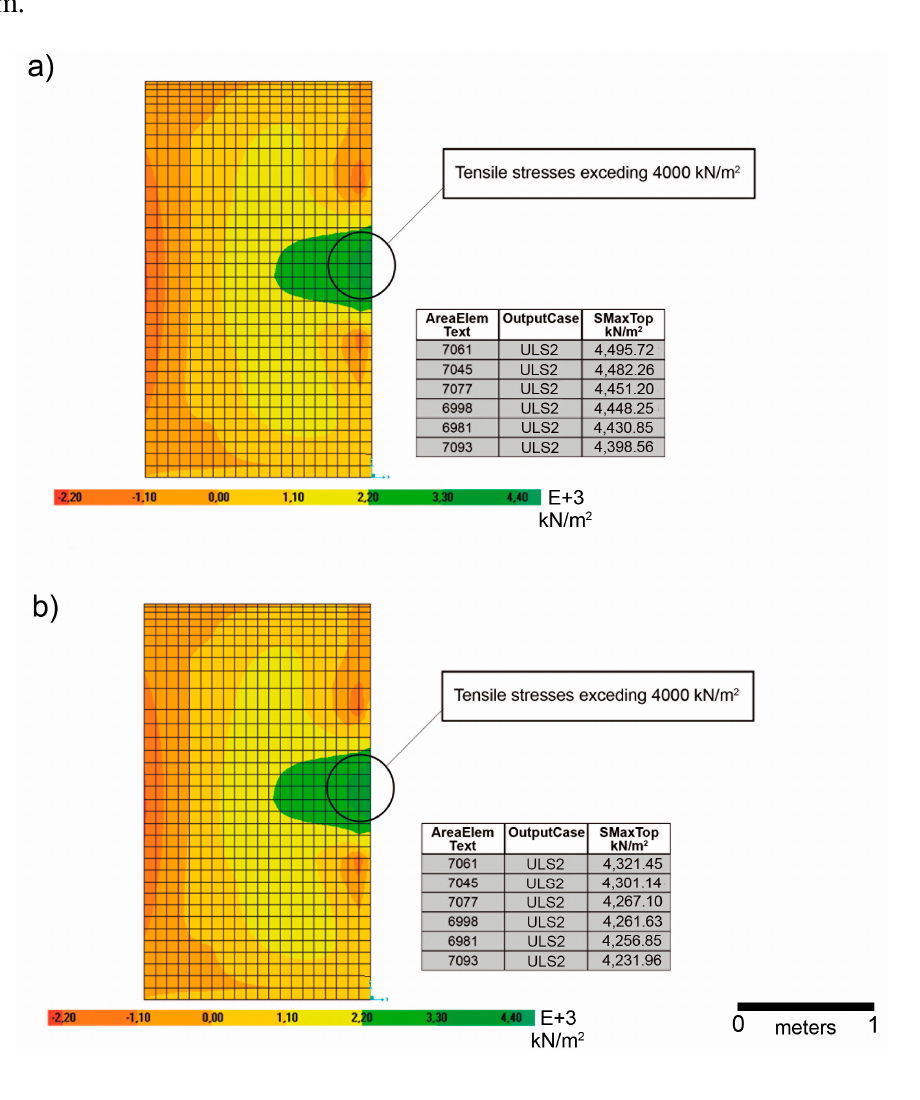
Figure 12. ( a ) Maximum principal tensile (kN/m 2 ) for the elevation wall with a thickness of 0.38 m; ( b ) maximum principal tensile (kN/m 2 ) for the elevation wall with a thickness of 0.42